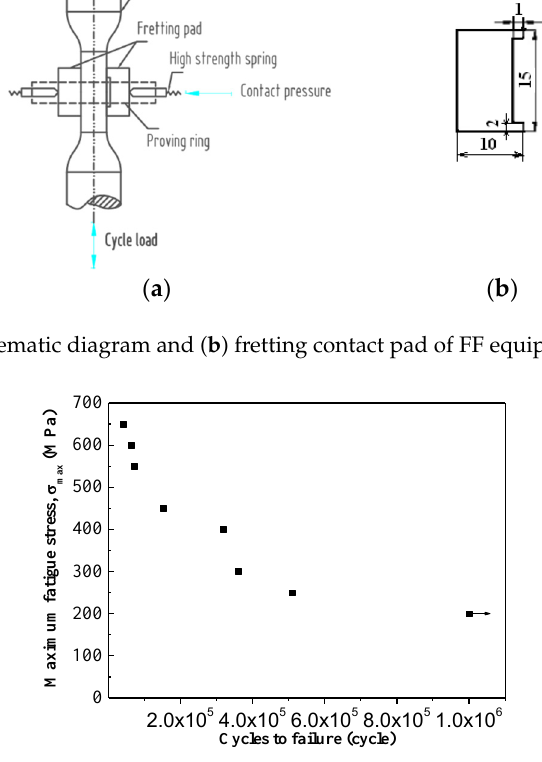
Figure 5. FF life of Ti6Al4V base with maximum fatigue cyclic stress (S ‐ N curve).